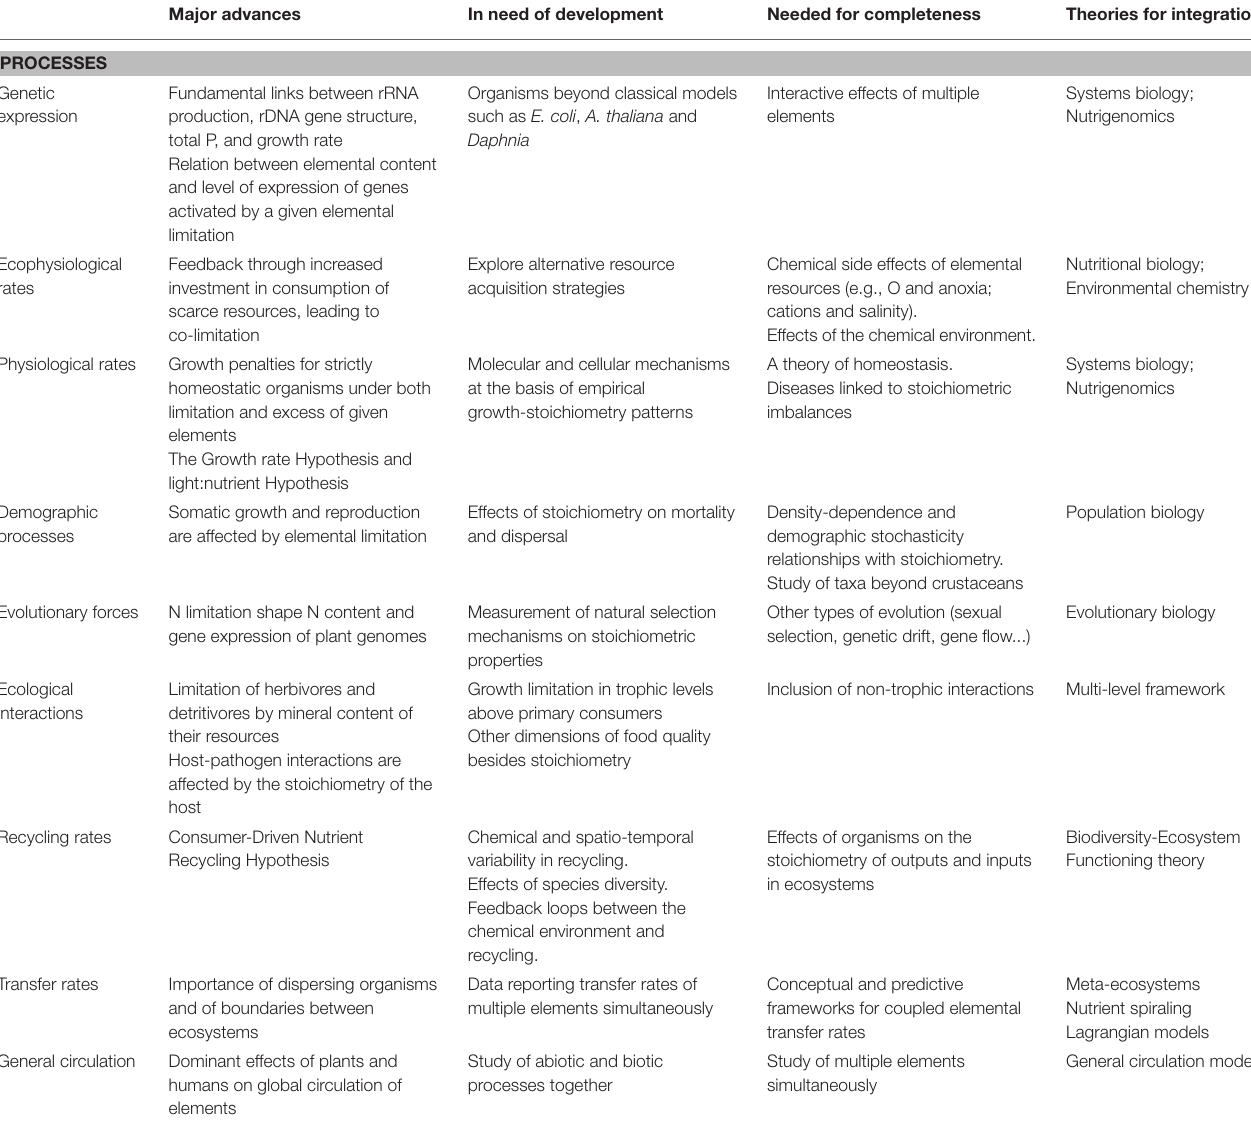
TABLE 2 | Brief summary of the major advances at each biological level of our framework for a molecule-to biosphere stoichiometry theory and of the elements of understanding identified as in need of improvement for each process of our framework for a molecule-to biosphere stoichiometry